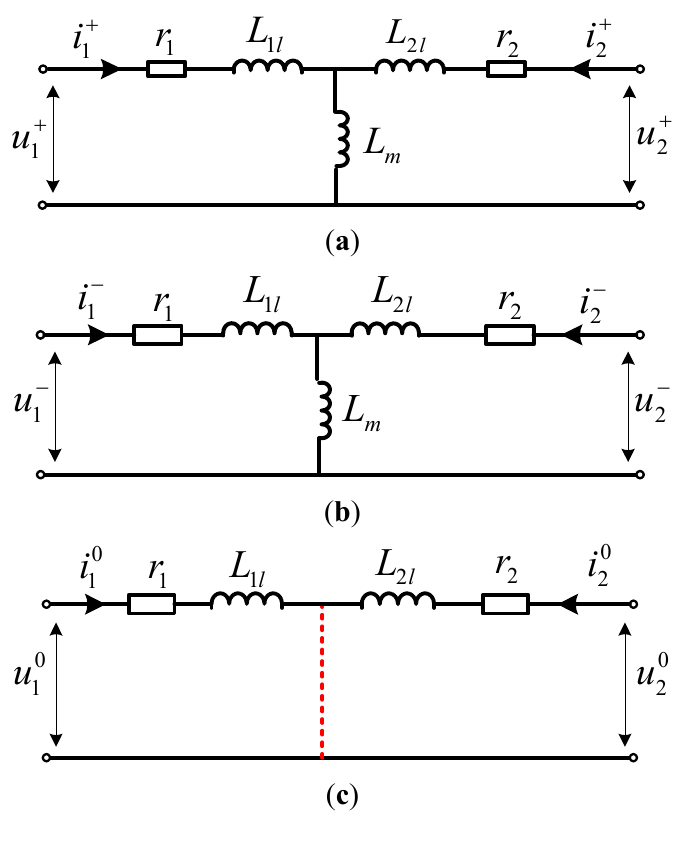
Figure 3. The ISC equivalent circuits for the three-limb transformer: ( a ) IPSC; ( b ) INSC; ( c )